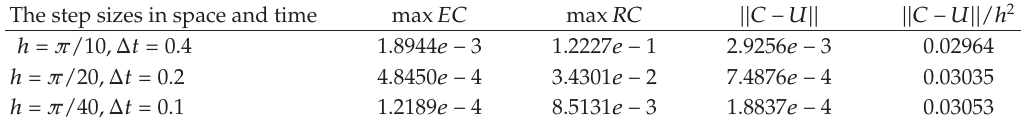
Table 3: The comparison of the maximum absolute error, the maximum relative error, and L 2 error at T (cid:9) 2. The step sizes in space and time